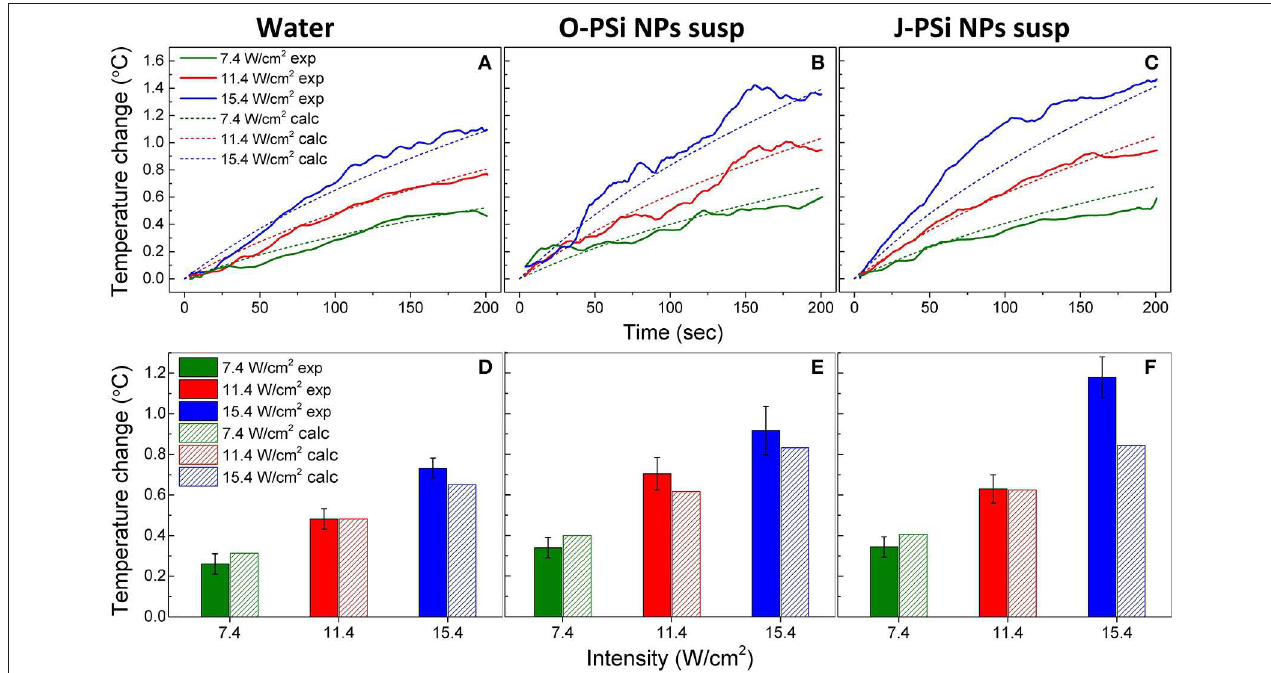
FIGURE 5 | The temperature rise in distilled water (A) , the suspension of O-PSi NPs (B) , and the suspension of J-PSi NPs (C) at the concentration of 1 g/l induced by US with the intensities of 7.4, 11.4, and 15.4 W/cm 2 . Experimental results are shown by the solid lines, while the dashed lines represent the simulated data. Temperature increase in distilled water (D) , the suspension of O-PSi NPs (E) , the suspension and J-PSi NPs (F) after the first 100s of exposure to US. The solid bars stand for the measured temperatures and the dashed bars for the calculated ones. The error bars indicate s.d. of the residual statistics obtained after non-linear fitting of the experimental heating curves (adj. R -squared >